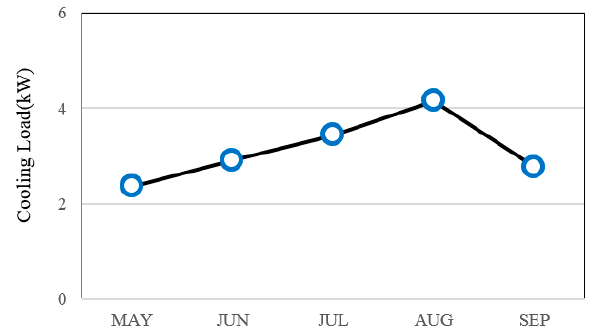
Figure 12. The peak load of cooling season.